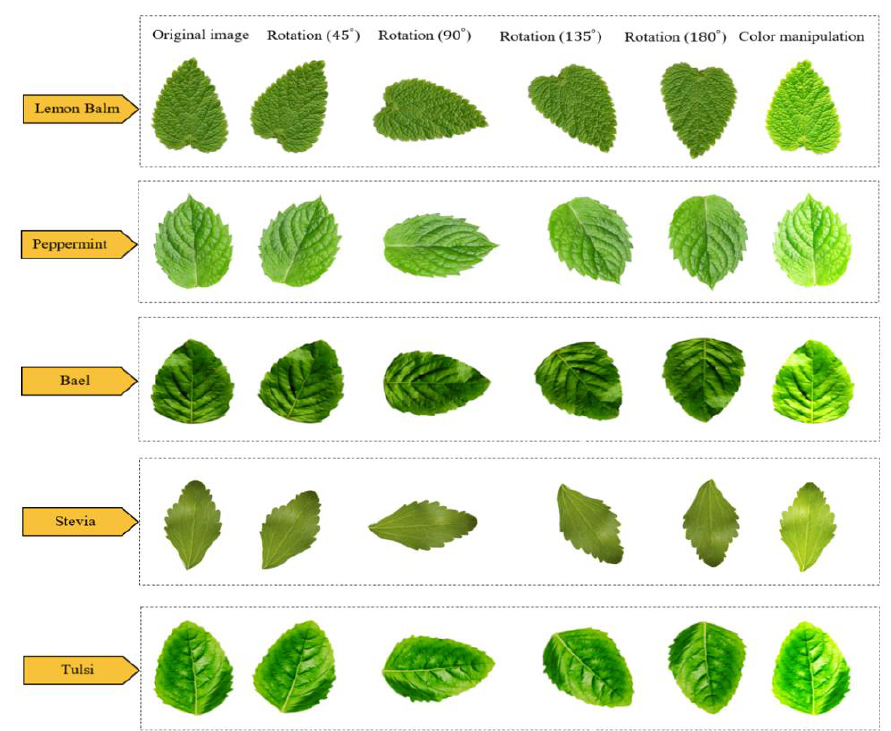
Table 1. Data splitting for training and testing in the proposed CNN.